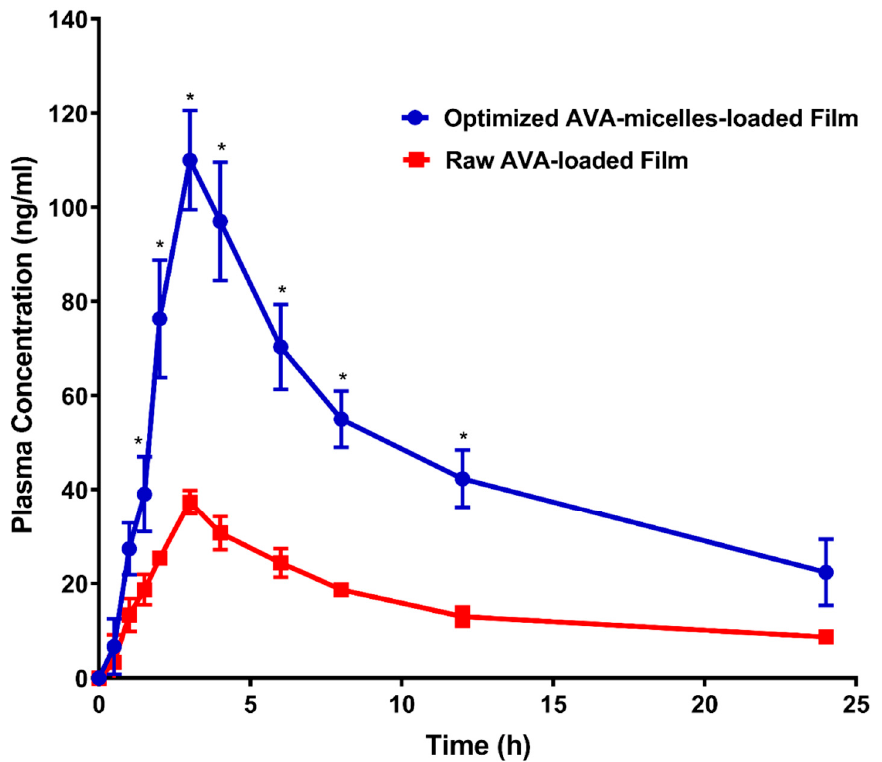
Figure 5. Avanafil plasma time concentration curves after transdermal application of raw AVA-loaded film and optimized AVA-MM-loaded film. Data represent the mean value ± standard deviation (SD). * Significant at p < 0.05. Table 5. Pharmacokinetic parameters after transdermal application of a single dose (20 mg/kg) of the optimized AVA-MM-loaded transdermal film compared with raw avanafil-loaded film.